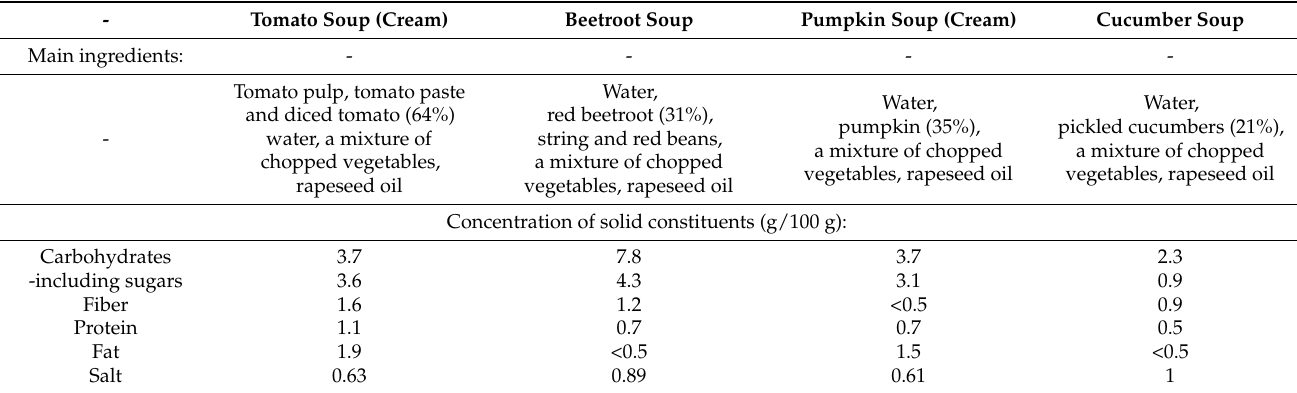
Table 1. Main ingredients and composition of selected commercial vegetable